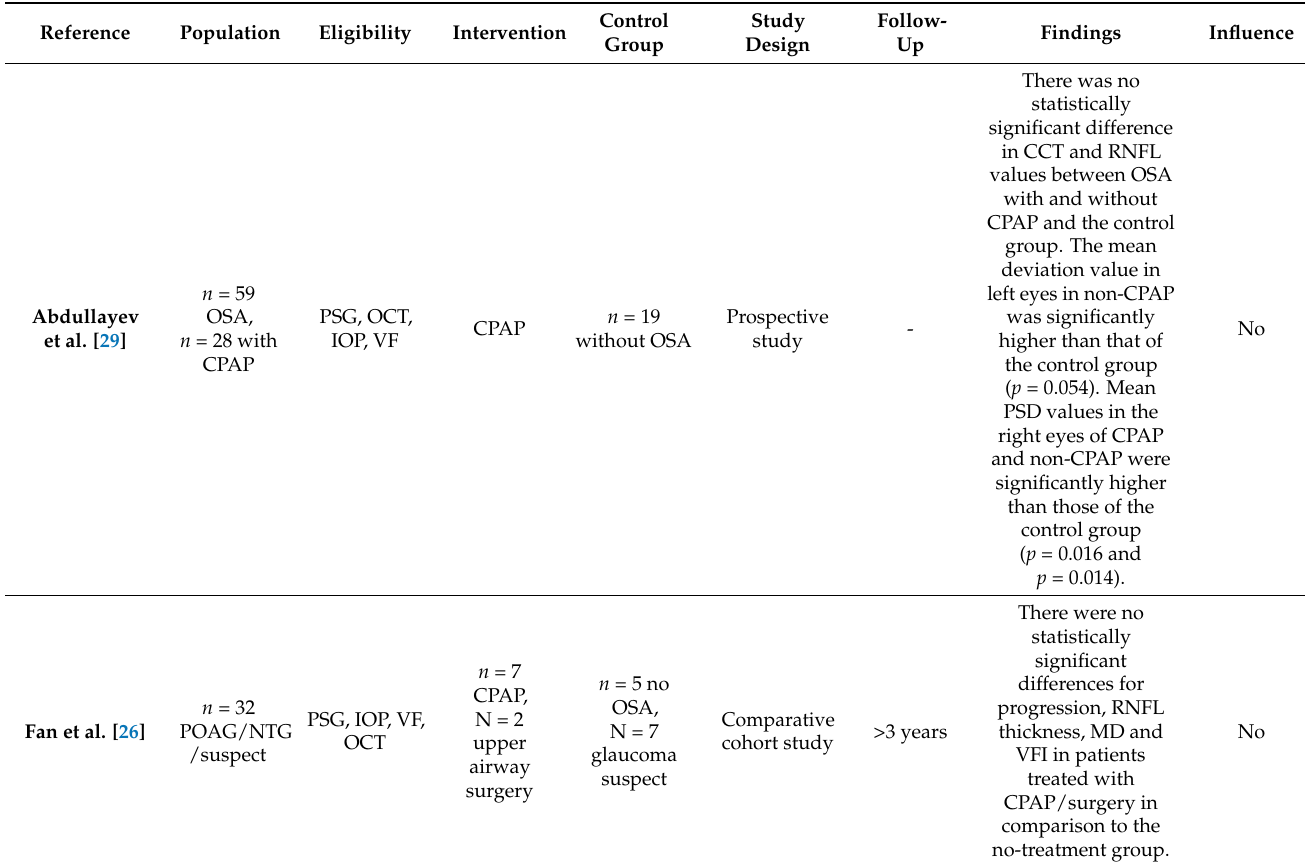
Table 5. Effect of treatment of OSA on intraocular